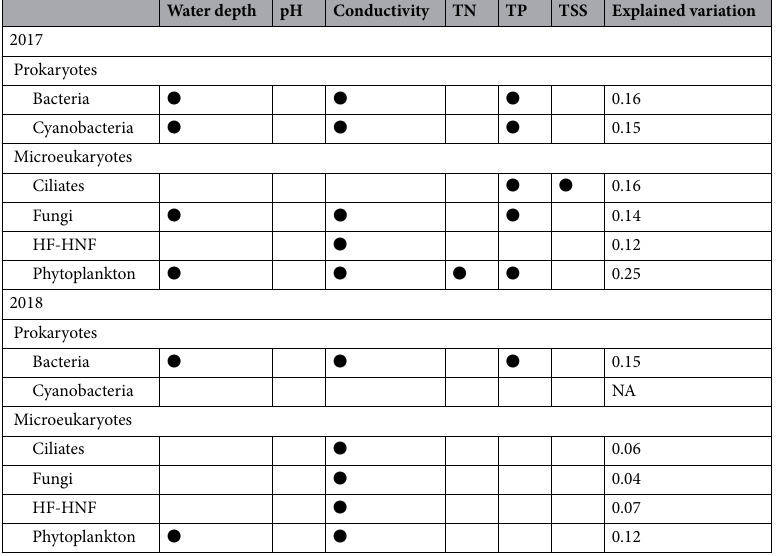
Table 2. Significant environmental variables (p < 0.05) of the OTU composition of prokaryotic and microeukaryotic functional groups based on separate CCAs (presented in the supplementary material, Figs. S1, S2).